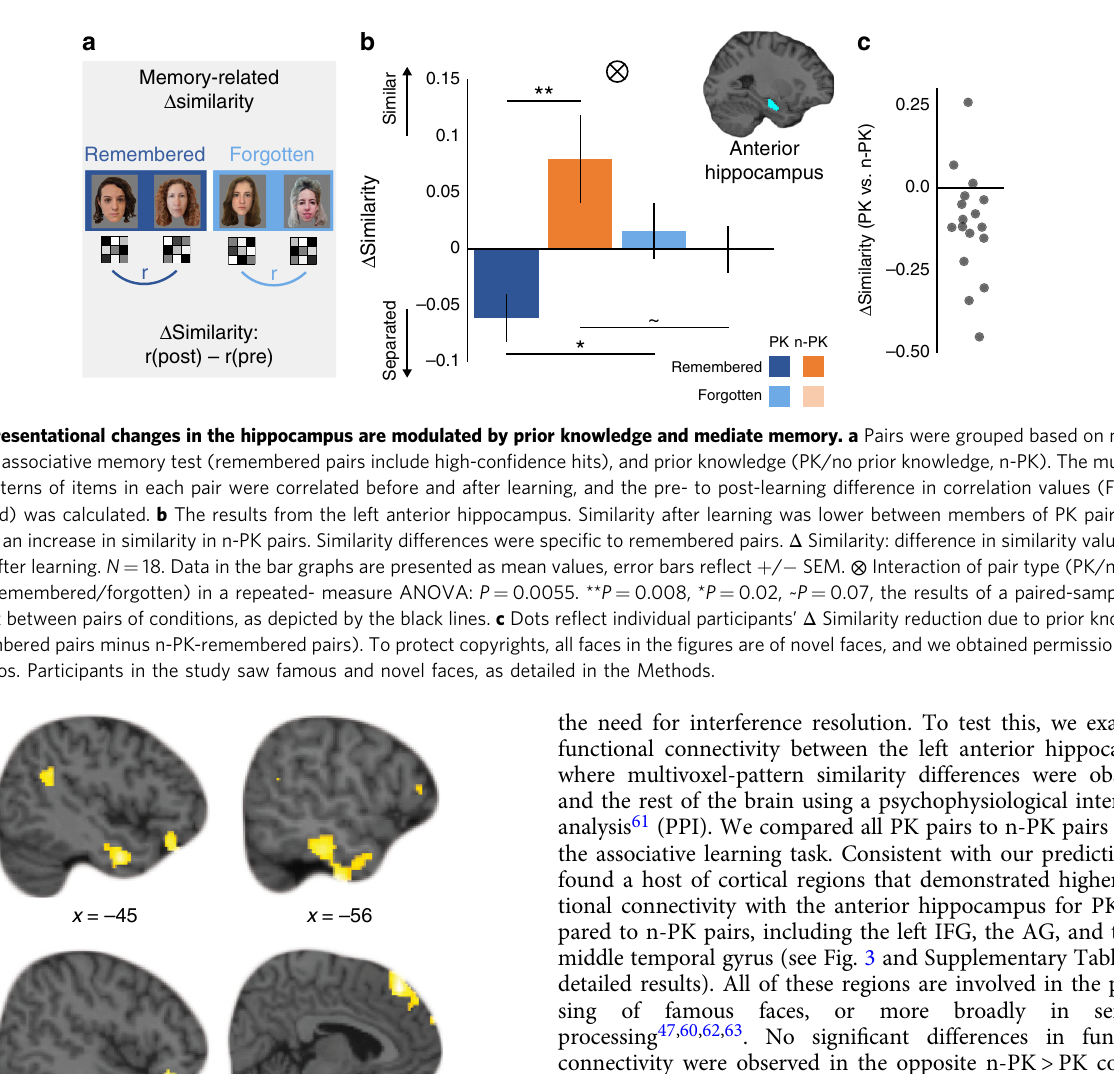
this case, the items ’ representations became more separated.